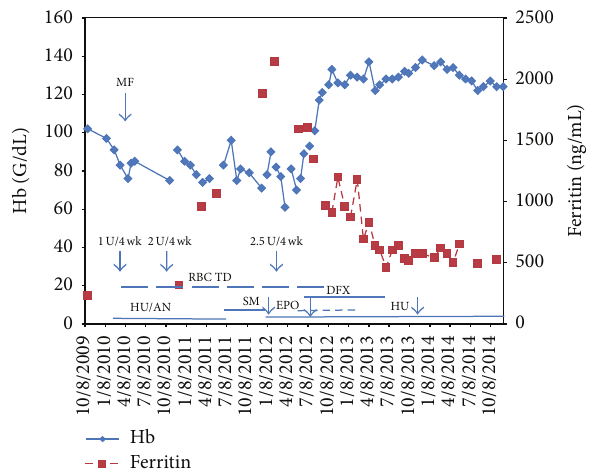
Figure 1: Clinical course of a patient with RARS-T evolved to myelofibrosis. Red blood cell transfusion dependence (RBC TD) started in 2010 and ended in August 2012, with number of RBC units (U) per 4 weeks (wk) indicated by the arrows. Hemoglobin (Hb) levels are pretransfusion measurements during the period of RBC TD and are otherwise regular measurements. Hydroxyurea (HU) and/or anagrelide (AN) were given from February 2010 to June 2011 with multiple dose adjustments to keep the platelet count less than 1000 × 10 9 /L. These were stopped as a requirement of a clinical trial of pomalidomide versus placebo (study medication indicated by SM); SM was given from July 2011 to January 2012 and stopped for lack of response. HU was resumed at doses of 2, 1.5, and 1g/day, respectively, as indicated by the arrows (left to right), to keep the platelet count less than 1000, 400, and 400 × 10 9 /L, respectively. Erythropoietin (EPO) was started in May 2012 at 40,000 U/wk and stopped in January 2013 because of a Hb of 130g/dL. Deferasirox (DFX) was started in June 2012 (5 weeks after EPO) at a dose of 1500 mg/day (20mg/kg/day). The patient’s last RBC transfusion was on August 7,